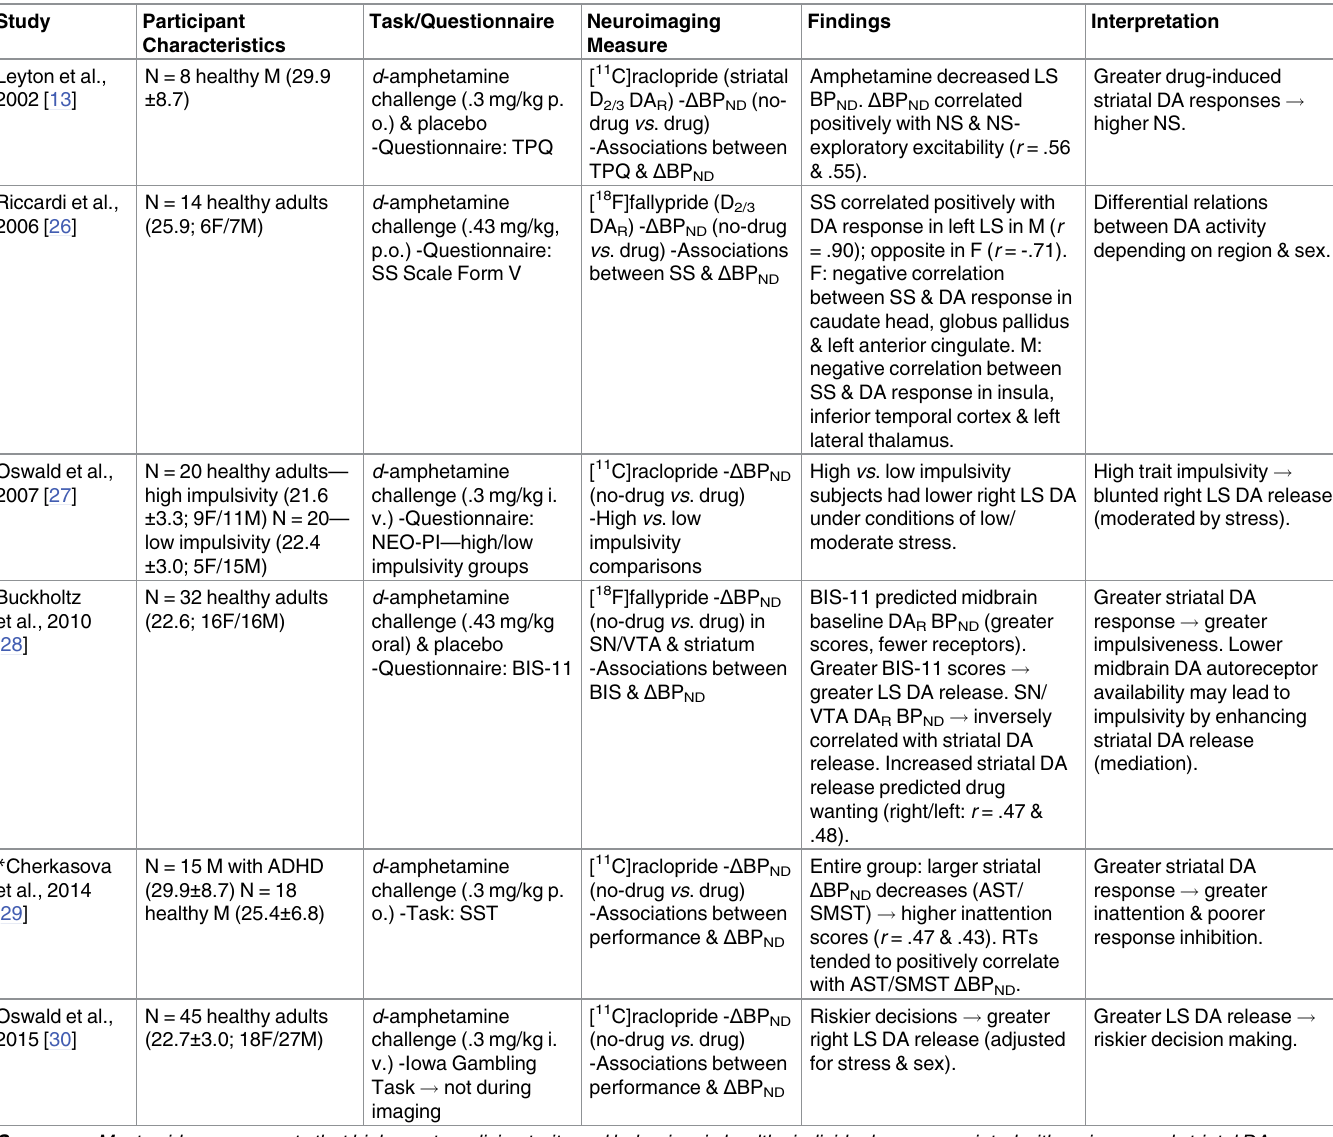
Table 2. Associations between amphetamine-induced striatal dopamine release& externalizing personality traits.